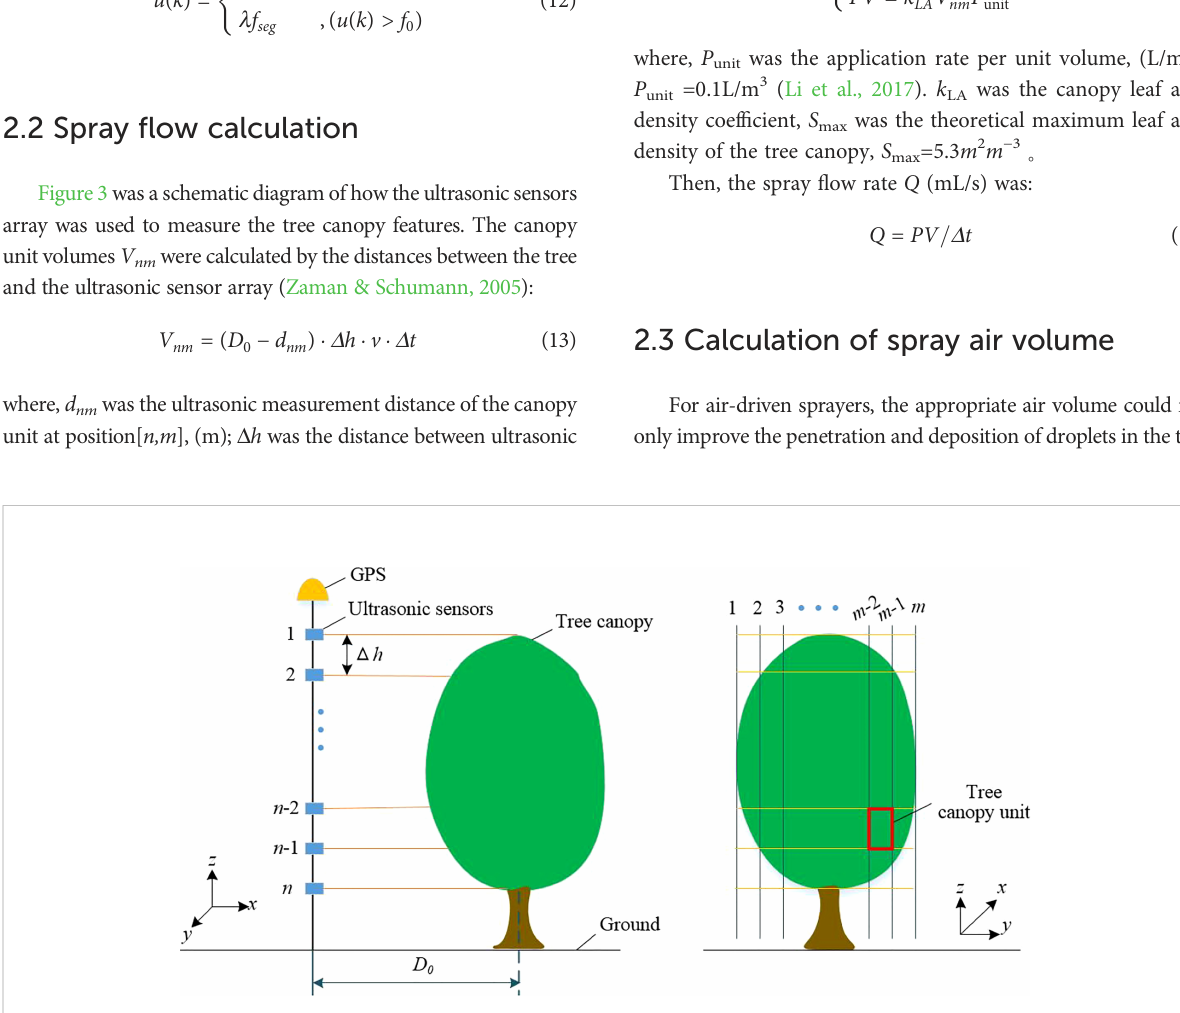
FIGURE 3 Schematic diagram of ultrasonic sensor detecting tree canopy feature